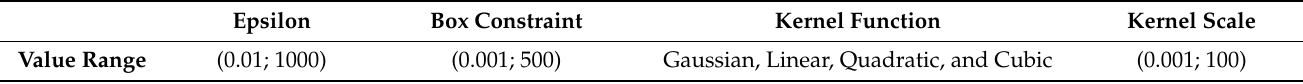
Table 8. Hyperparameters of the SVM model.